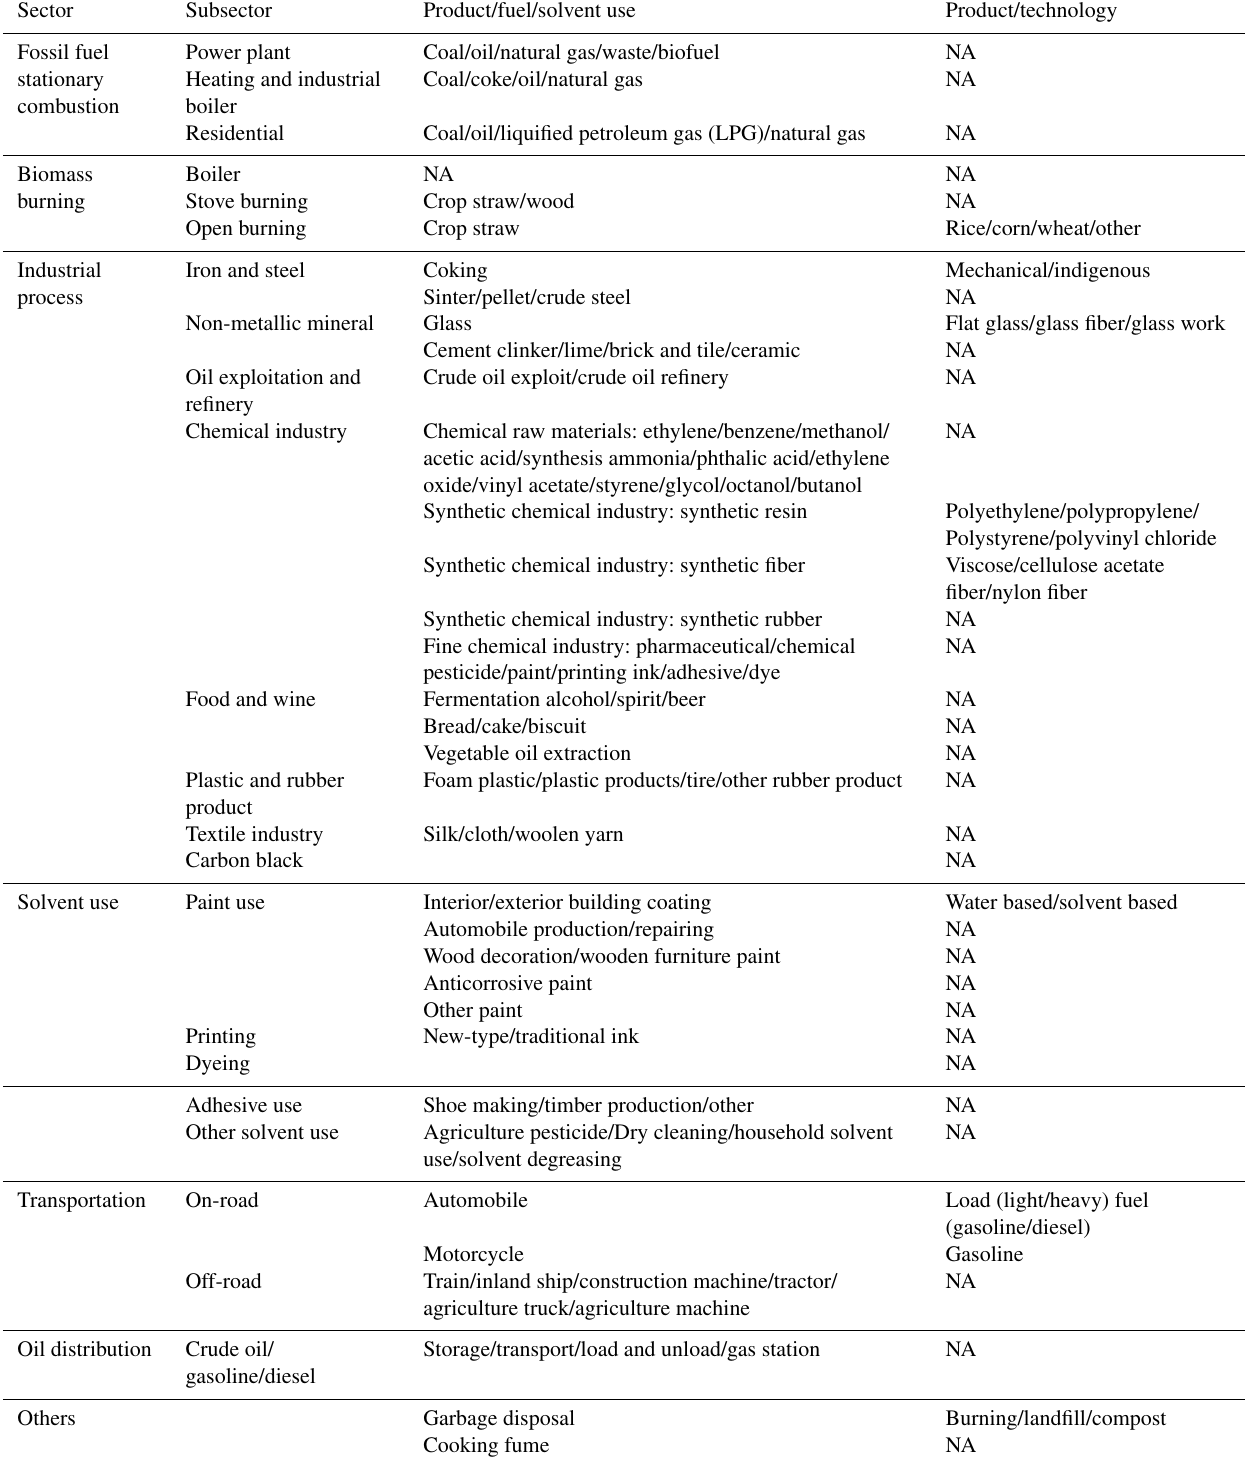
Table 1. Categories of anthropogenic NMVOC emission